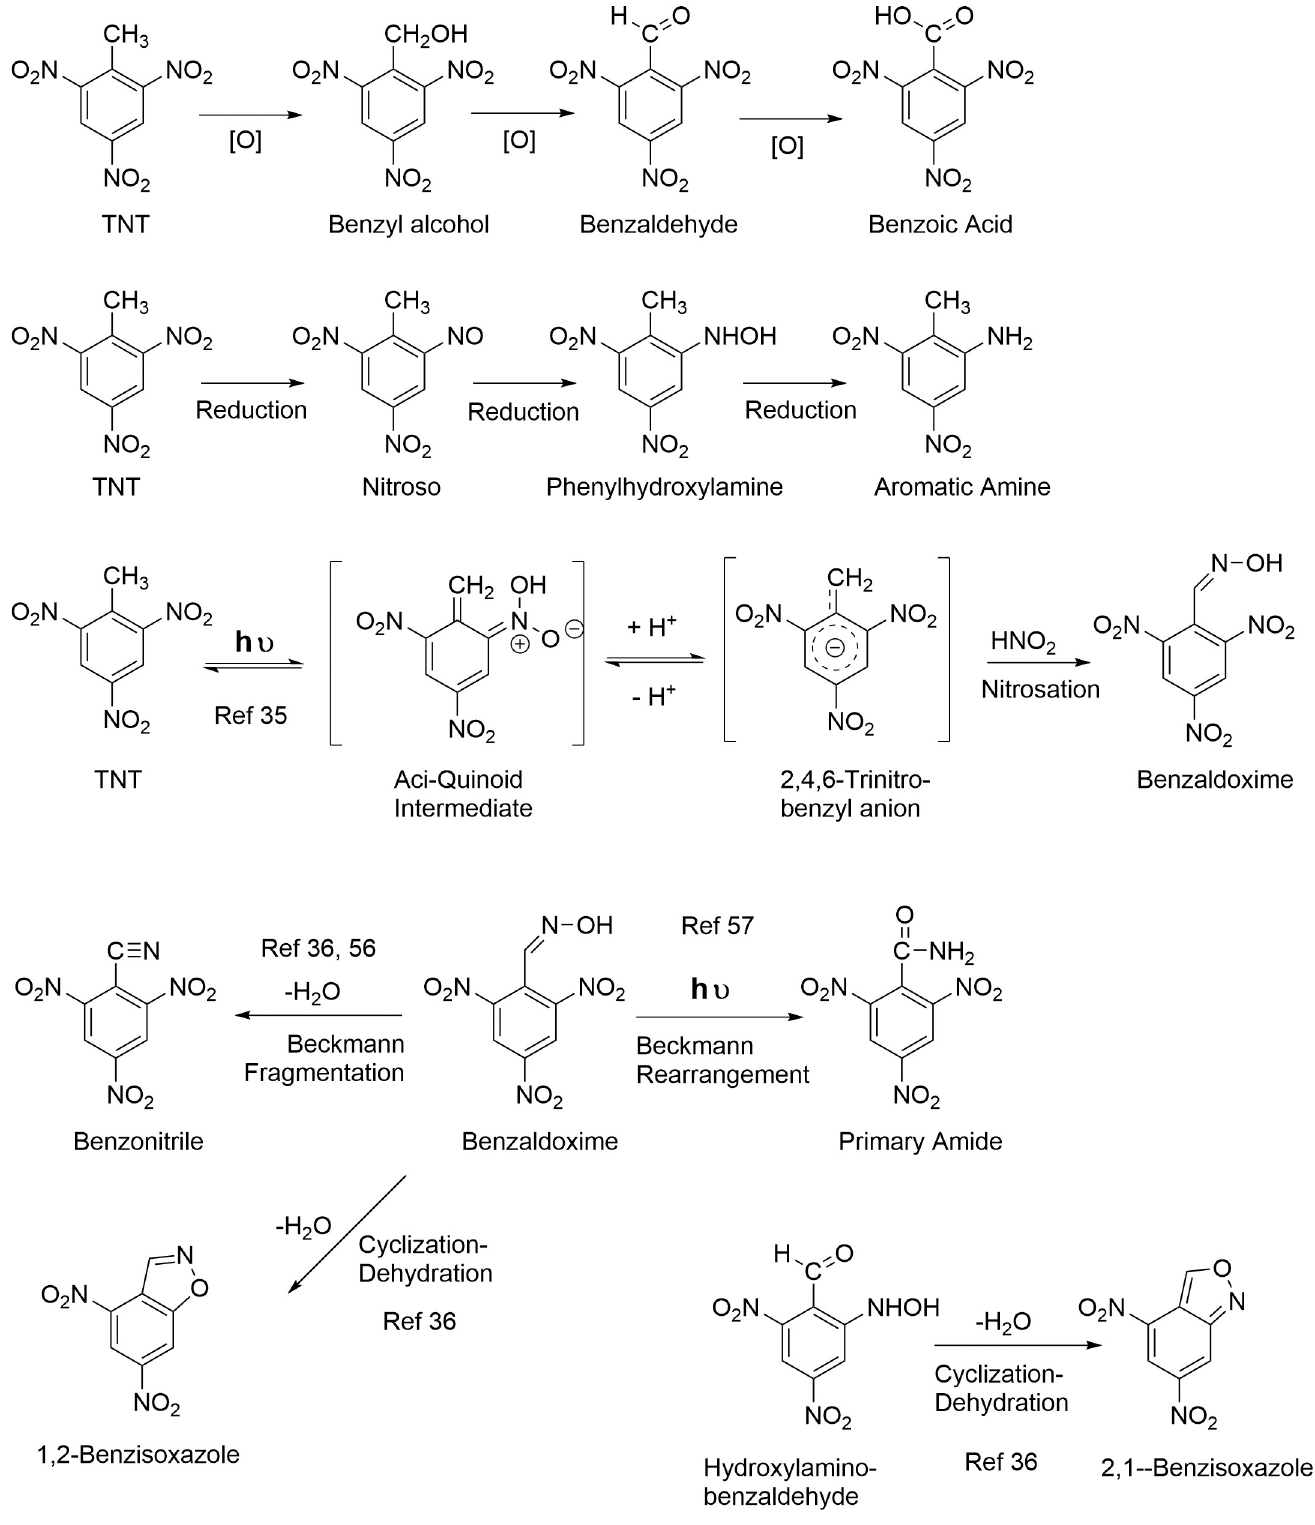
Fig 1. Photochemical transformation reactions of TNT.